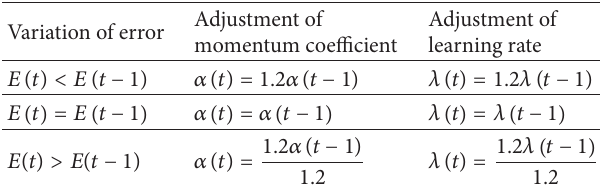
Table 1: Parameter adjustment in the improved BPNN model. Variation of error